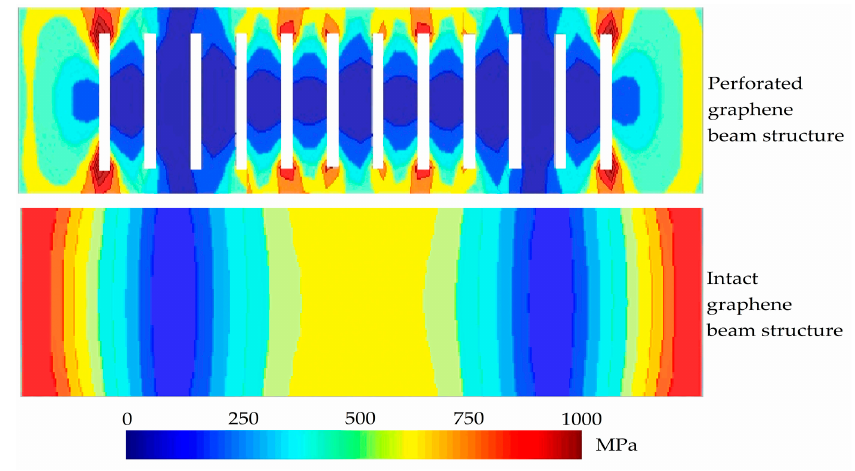
Figure 13. Comparison of von Mises stress contour plot from the top view (unit: MPa) between intact and perforated graphene-based NEM switch.